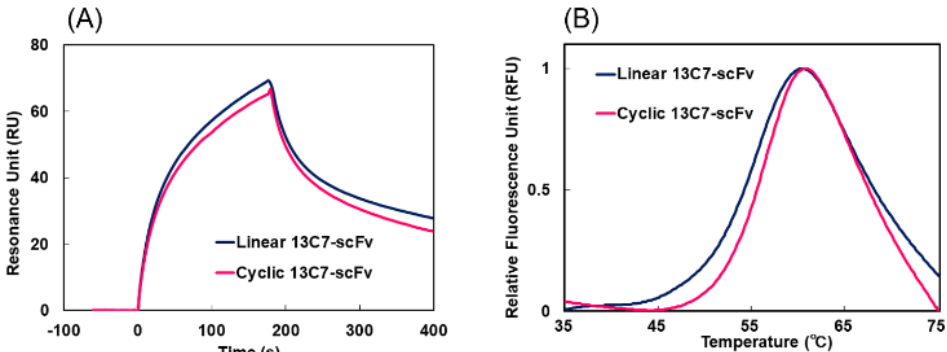
Figure 5. ( A ) Surface plasmon resonance (SPR) analysis of the binding affinity for the peptide derived from Lys 9 acetylated histone H3 at 25 °C for linear (blue) and cyclic 13C7-scFv (magenta). ( B ) Differential scanning fluorometry (DSF) analysis of the thermal stability of linear (blue) and cyclic 13C7-scFv (magenta).